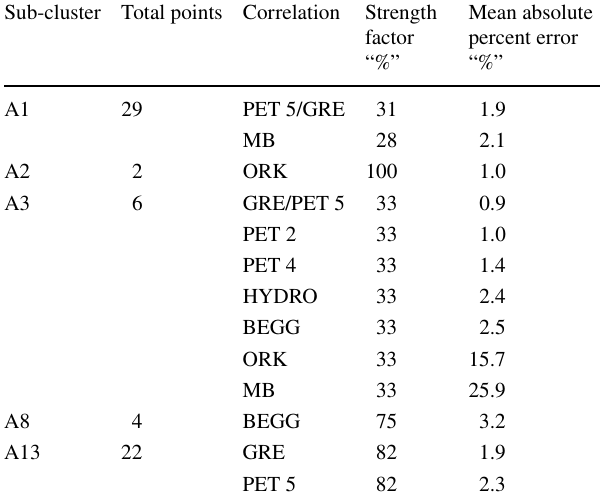
Table 9 Best correlations for cluster (A) Sub-cluster Total points Correlation